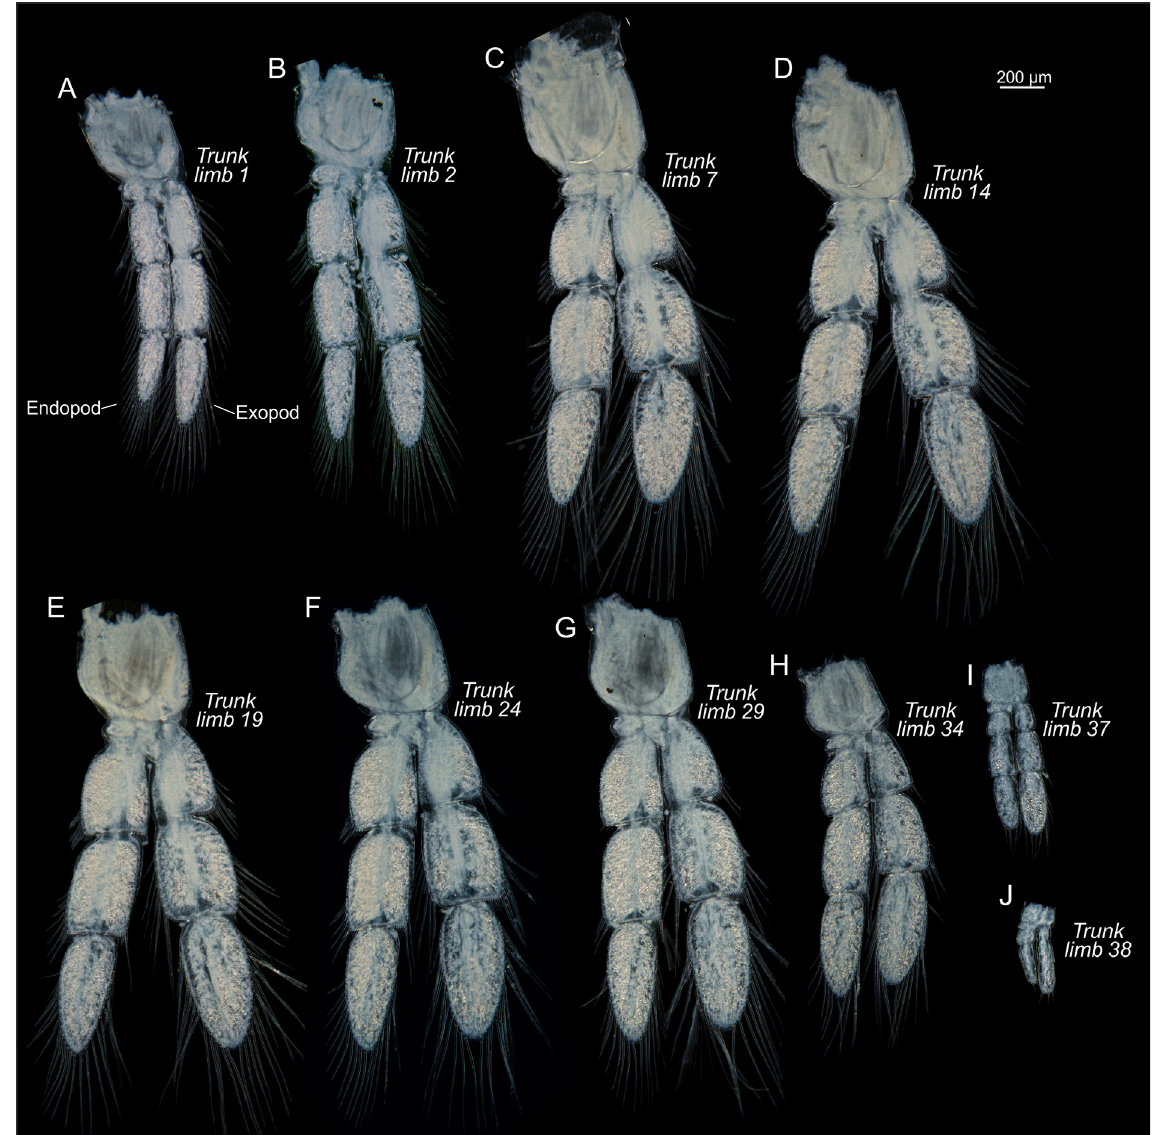
Fig. 9. Xibalbanus cozumelensis sp. nov., holotype (ZMUC-CRU-4791), trunk limbs, left side from anterior, light microscopy. A–J . Selected trunk segments (number specified on figure). All to the same